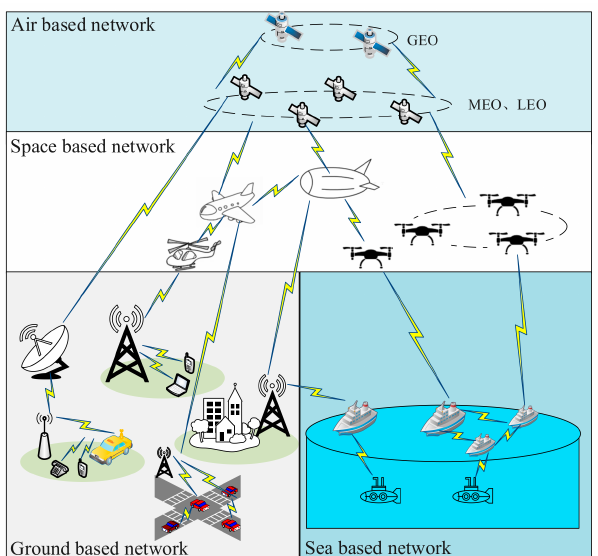
Figure 12. System topology of the space-air-ground-sea integrated emergency communication